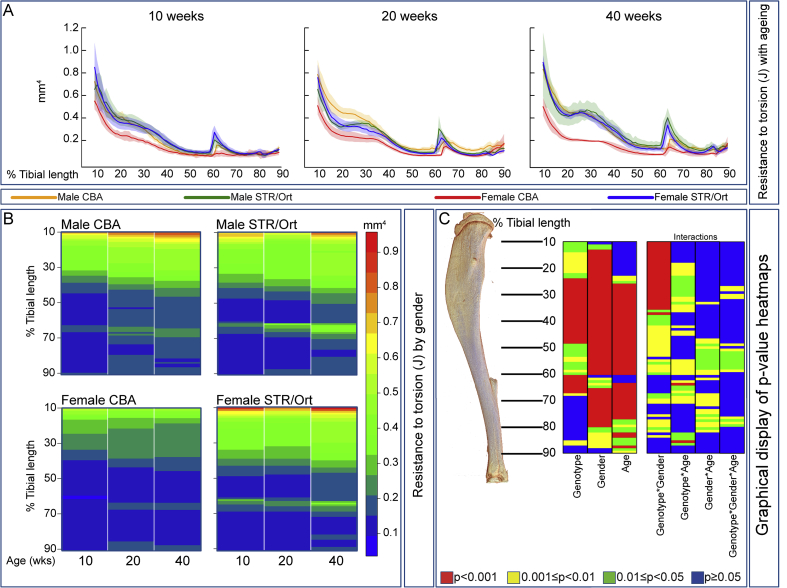
Analysis of J (measure of predicted resistance to torsion) along the entire length of the tibia. (A) J in male and female CBA (brown and red, respectively) and STR/Ort (green and blue, respectively) mice at 10, 20 and 40 weeks of age. (B) ‘Heat map’ representation of identical data-set (red-blue colour scale depicts average ellipticity) for male and female CBA (left) and male and female STR/Ort (right) enabling ready comparison (at each percentile of length) between 10, 20 and 40 weeks of age. (C) Statistical significance of differences in J (measure of predicted resistance to torsion) along the entire tibial shaft, represented as a heat map. The contributions of genotype (CBA vs STR/Ort), gender, age (10, 20 and 40 weeks), and their interactions at locations from 10 to 90% of tibial length are illustrated. Red P < 0.001, yellow 0.001 ≤ P < 0.01, green 0.01 ≤ P < 0.05 and blue P ≥ 0.05. Line graphs represent means with 95% CI. Group sizes were n = 5 for male and female CBA and STR/Ort mice.